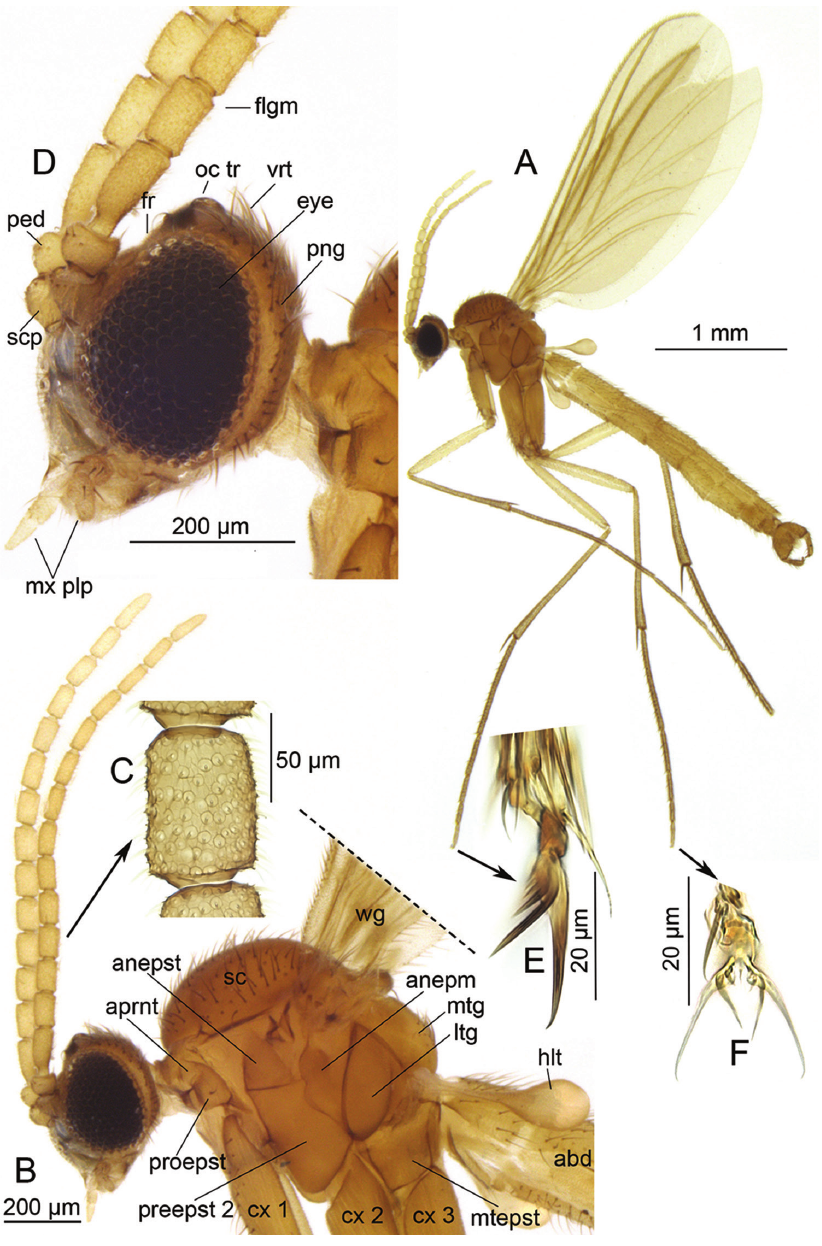
Figure 3. Kibaleana apicospinosa sp. n., male. A General habitus, lateral view B Head and thorax, lateral view C Fourth segment of flagellum, lateral view D Head, lateral view E Claw, lateral view F Claw, dorsal view. Abbreviations: abd = abdomen; anepst = anepisternum; anepm = anepimeron; aprnt = anteprono- tum; cx = coxa; eye = compound eye; flgm = flagellar segment; fr = frons; hlt = halter; ltg = laterotergite; mtepst = metepisternum; mtg = mediotergite; mx plp = maxillary palpus; oc tr = ocellar triangle; ped = pedicel; png = postgena; preepst 2 = preepisternum 2; sc = scutum; scp = scape; vrt = vertex; wg =